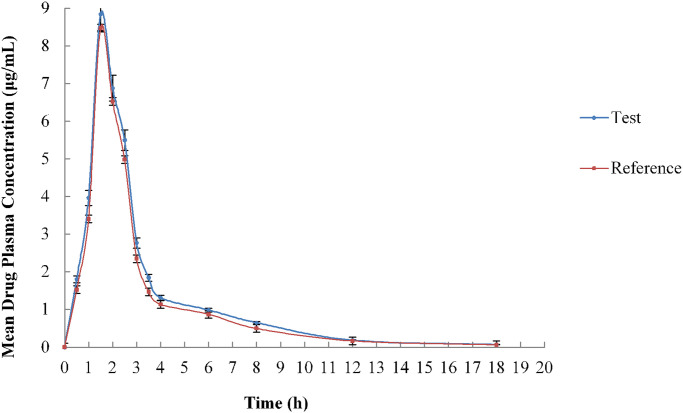
Mean plasma drug concentration of aceclofenac IR trial formulation and the reference product (n = 12).